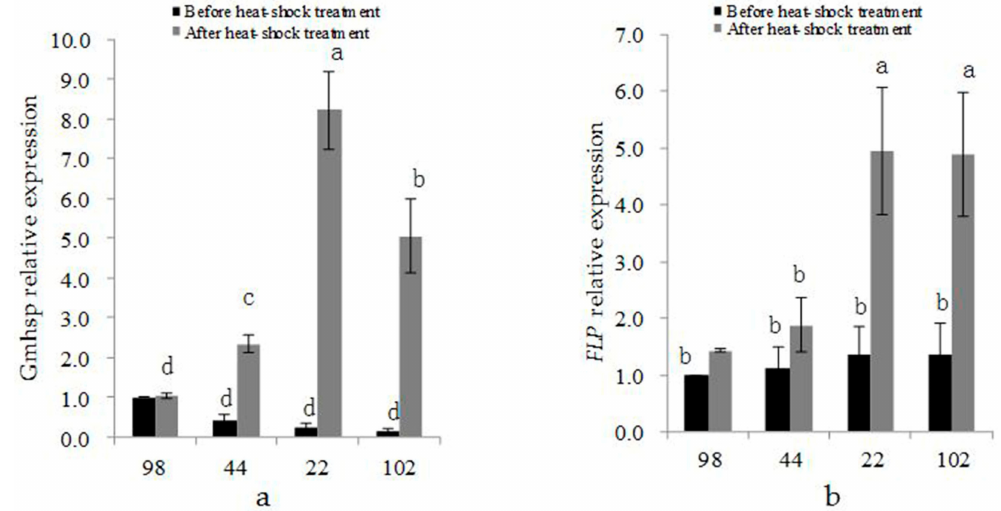
Figure 9. Expression of ( a ) Gmhsp17.6-L and ( b ) FLP before and after heat-shock treatment in transgenic lines 98-3-2 (98), 44-3-1 (44), 22-2-2 (22), and 102-2-2